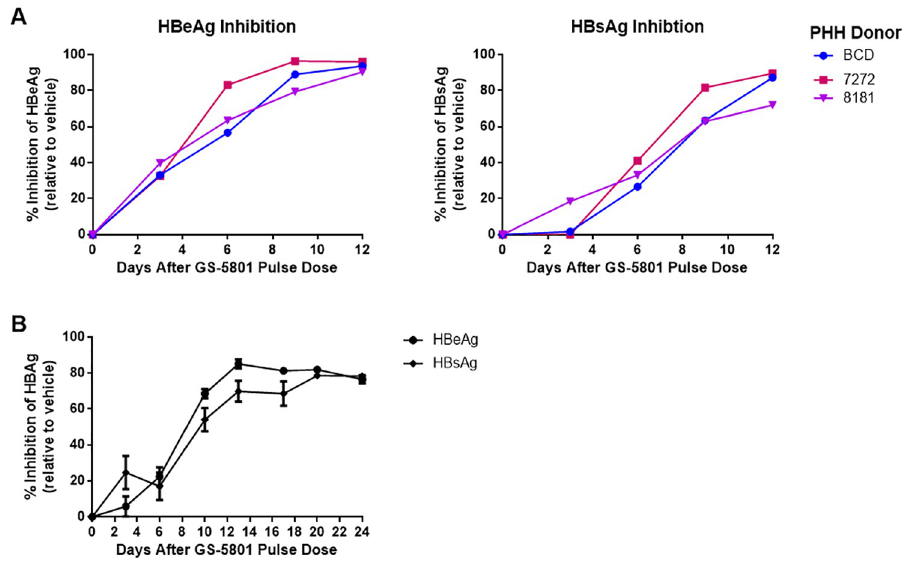
Fig 4. A single dose of GS-5801 confers sustained HBV antiviral activity in PHH. (A) PHH from three donors (BCD, 7272, and 8181) were infected with HBV for three days prior to initiation of GS-5801 treatment. PHH were treated once for two hours with vehicle or 10 μ M GS-5801. Compound was removed by replacing the medium with fresh medium without drug or vehicle. At the timepoints shown, levels of secreted HBeAg and HBsAg were measured by immunoassay for 12 days. Data are shown as the percentage inhibition of HBeAg or HBsAg in GS-5801 treated PHH relative to vehicle treated PHH. (B) PHH from donor BCD were infected with HBV for three days prior to initiation of GS-5801 treatment. PHH were treated once for two hours with vehicle or 10 μ M GS-5801. Compound was removed by replacing the medium with fresh medium without drug or vehicle. At the timepoints shown, levels of secreted HBeAg and HBsAg were measured by immunoassay for 24 days. Data are shown as the average